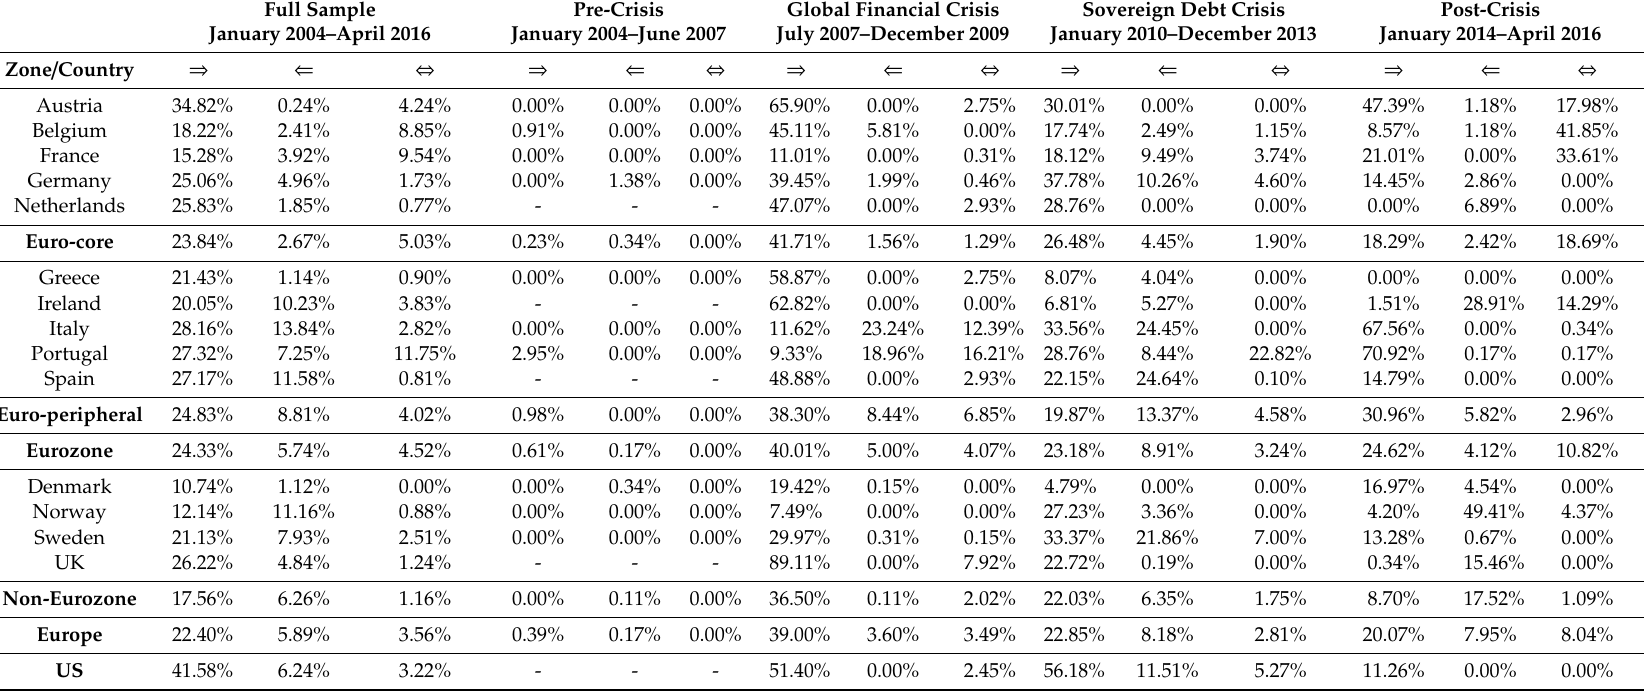
Table 2. Granger causality test results: stock indices and sovereign CDS